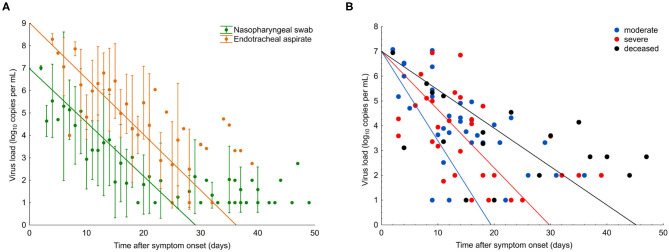
SARS-CoV-2 viral load in COVID-19 patients with different disease severity. (A) Viral load from nasopharyngeal swabs (green) and endotracheal aspirates (orange). Data points are mean; error bars indicate SD; slopes represent best fit. (B) Viral load from nasopharyngeal swabs from all patients (n = 29). Data points indicate viral load in individual samples; slopes represent viral RNA decline in patient groups, as assessed by Generalized Estimation Equations (GEE) applying an unstructured correlation matrix. Group one, moderate (blue); group two, severe (red), and group three, deceased (black).